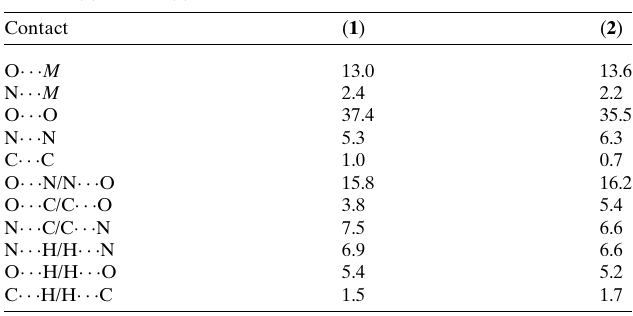
Table 5 Contributions of the different kinds of the contacts (%) to the Hirshfeld surfaces of individual anions in ( 1 ) a and ( 2